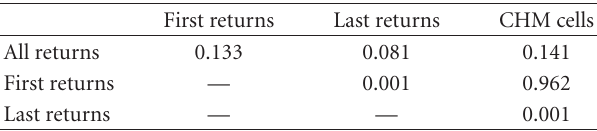
Table 3: P -values of pair-wise two sample t -tests for quadratic mean heights derived from di ff erent data